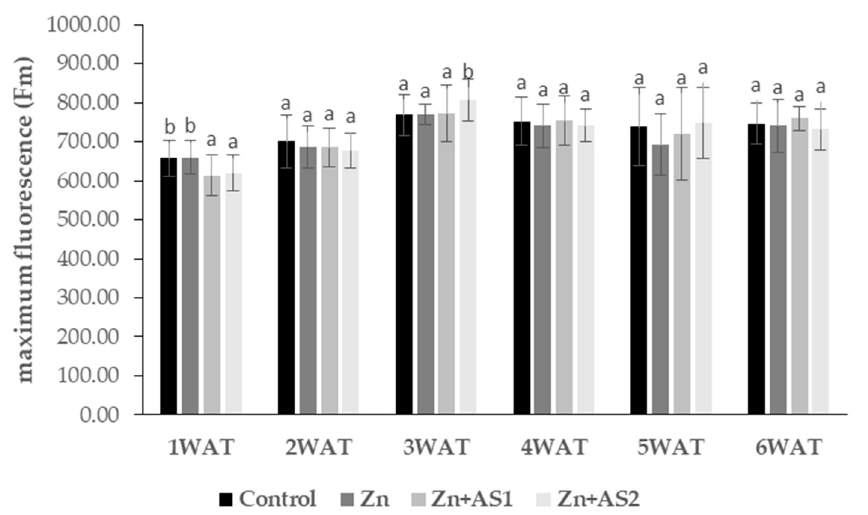
Figure 3. The effect of different foliar treatments (Zn, Zn+AS1, and Zn+AS2) on the maximum fluorescence (F m ) in the second youngest and fully developed leaves of maize 1, 2, 3, 4, 5, and 6 WAT. n = 20 ± S.D. Lower case letters (a, b) show the significant differences among the treatment based on sampling time. WAT: week(s) after treatment.